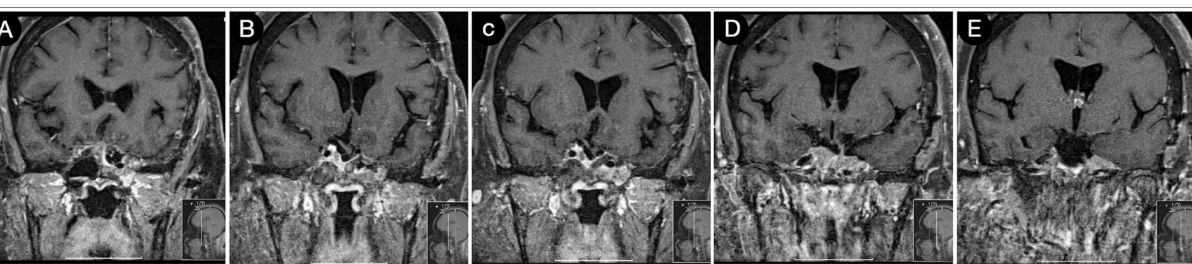
Figure 21. ( A – E ) Postoperative coronal T1-weighted contrast-enhanced MRI. Scale bar: 5